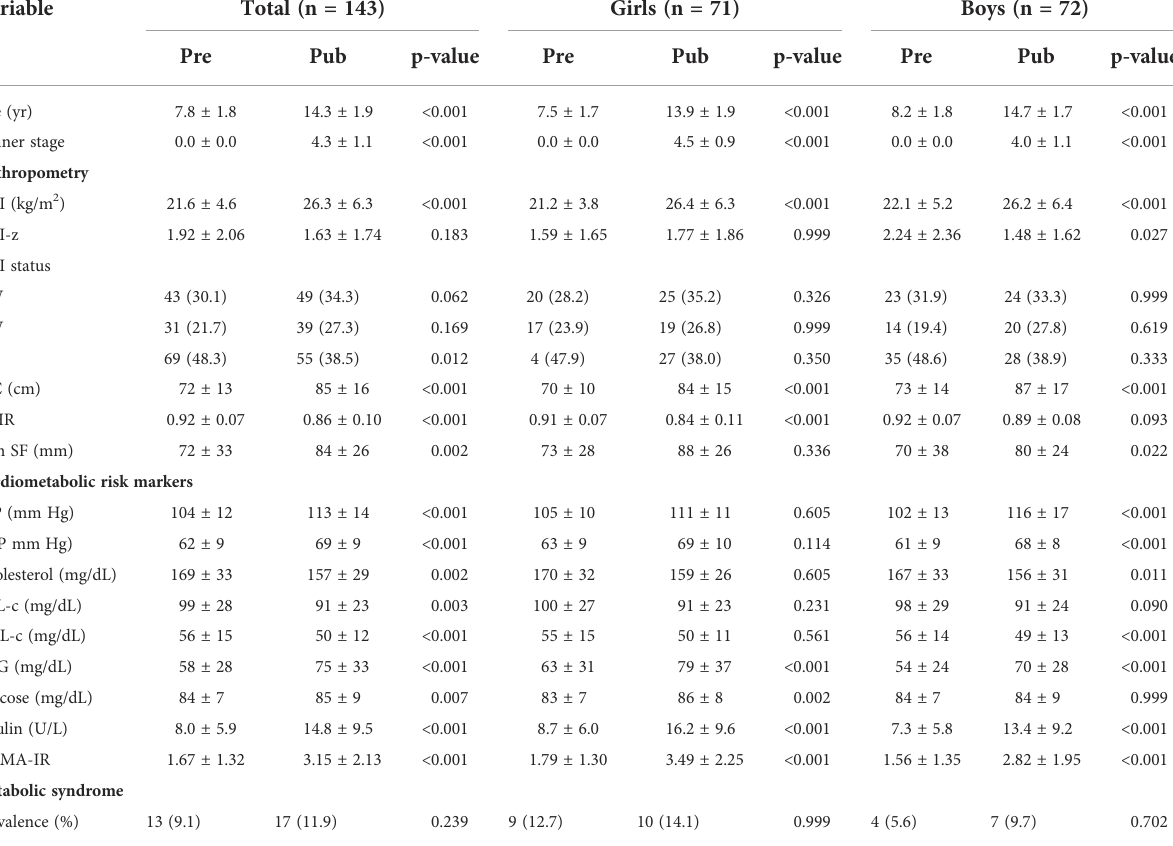
TABLE 1 Participant characteristics, anthropometry and cardiometabolic risk markers grouped by pre and pubertal stage and by sex. Variable